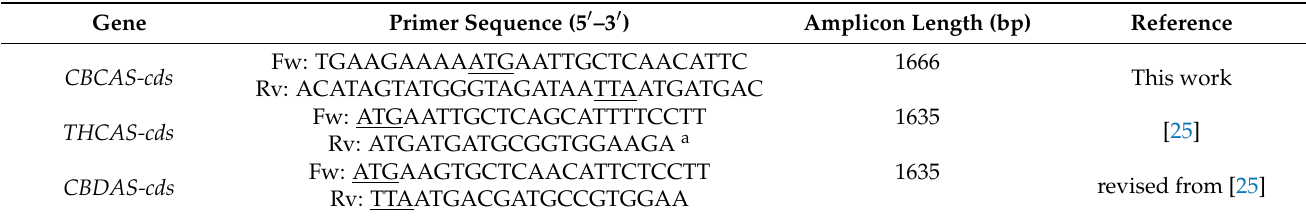
Table 2. List of primer pairs used for full length coding sequences (cds) amplification. Forward (Fw) and Reverse (Rv) primer sequences, amplicon length (bp) and references are given. Start and stop codons are underlined for each